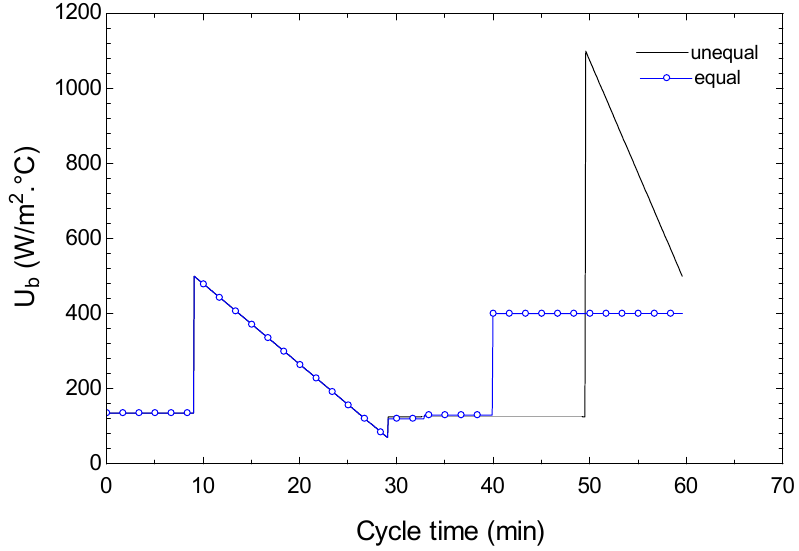
Figure 6. Overall heat transfer coefficient profile for the adsorber. Variation of the desorbed water in the condenser with cycle time is predicted in Figure 7. It is clear that the condensate water rises sharply due the flow of the vapor from the desorber, then after it decreases due to the decrease in the amount of water vapor in the condenser. During adsorption phase, it can be seen that the condensate water is of about 0.6 kg for equal state and 0.57 kg for unequal state. There is a difference of 5% in condensate water between the two states. The results demonstrated that the condenser performance, for given operating conditions, is not strongly dependent on the adsorption steps.